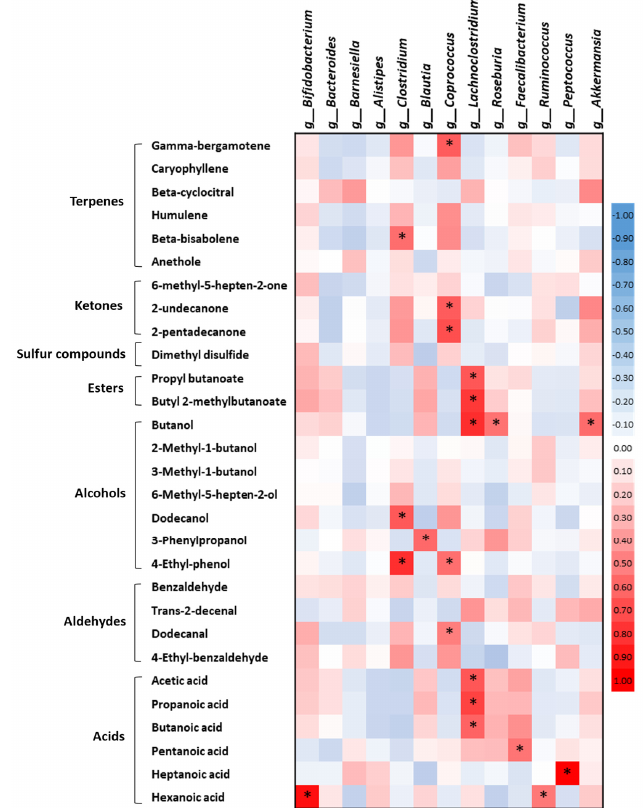
Figure 10. Associations of the fecal volatile organic compounds (VOCs) with the gut microbiota in Alzheimer’s disease (AD). A hierarchical heat map with the correlations between the fecal VOCs selected by the VIP score and the bacterial genera that were statistically significant in the ANOVA analysis. The red squares indicate a positive correlation while the blue squares indicate a negative correlation. The statistical analysis of the correlation coefficient was performed with a t -test. An asterisk indicates the statistical significance; (n = 10, control subjects; n = 12, AD patients).